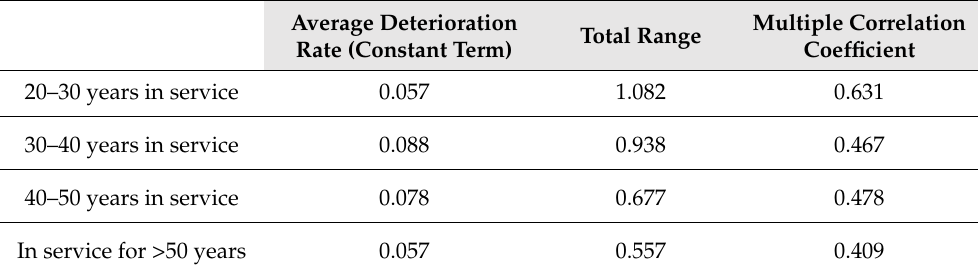
Table 3. Results of an analysis using Hayashi’s quantification